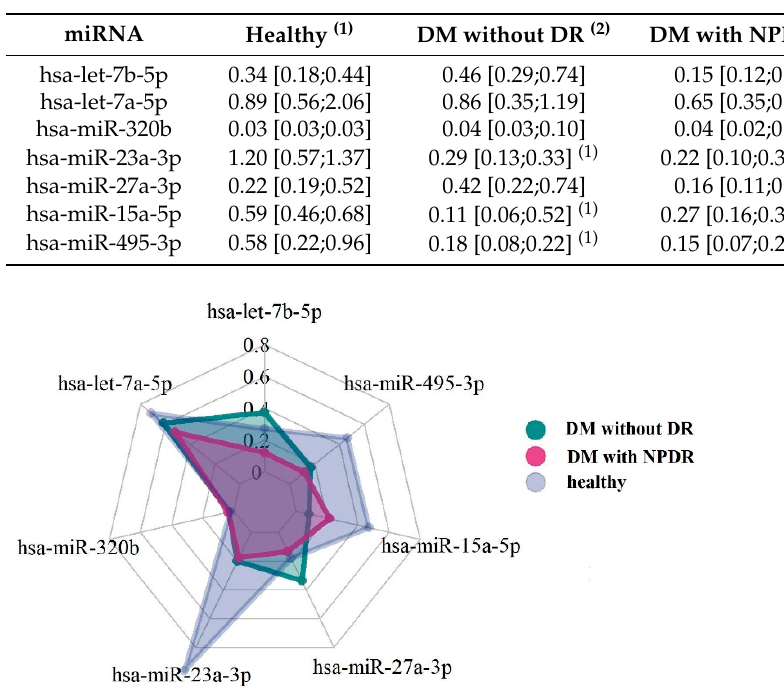
Table 3. Expression of miRNA levels in the three groups. All values are expressed as median (1st quartile; 3rd quartile). p -value results from the nonparametric test for independent samples. For analyzing the specific sample pairs for stochastic dominance, Dunn’s test was used. To show the pairwise differences, we assigned a number to each group: healthy = (1); DM without DR = (2); DM with NPRD = (3).